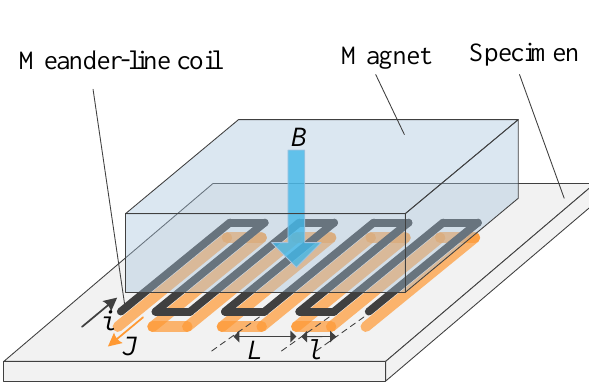
Figure 1. Schematic diagram of a meander-line coil electromagnetic acoustic transducer (EMAT).